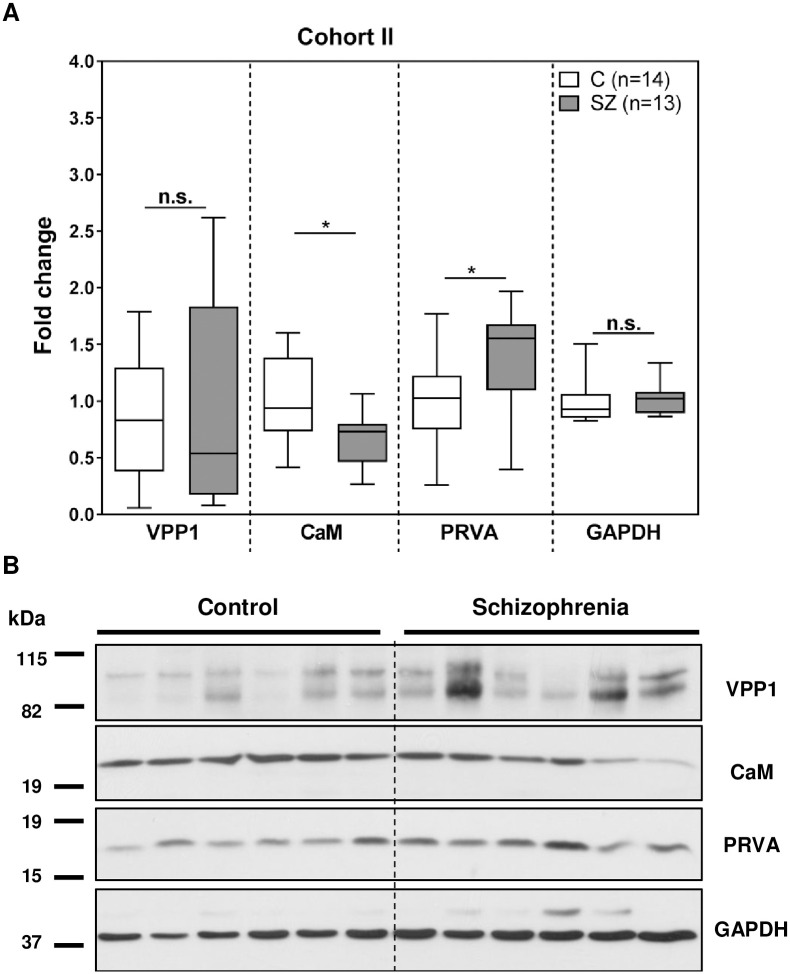
Validation analysis of hit candidate proteins by immunoblot in Cohort II.Protein extracts from samples of the post-mortem cerebellum of non-suicide chronic schizophrenia (SZ, n = 13) and control (C, n = 14) subjects (Table 1, Cohort II) were analysed by immunoblot for the same proteins as in Fig 1A and quantified by densitometry. (A) Protein levels for each protein were normalized to GAPDH values and to the mean of the control samples. Each box plot represents the median, interquartile range, and range of each group from at least two independent determinations. An outlier was detected for VPP1 protein values in the control group. Statistical analysis for comparison between case and control groups was performed using the t test for VPP1 and PRVA and the Mann-Whitney U test for CaM and GAPDH (n.s.-not significant, *p<0.05, ***p<0.001). (B) Representative Western blot images for VPP1, PRVA, CaM and GAPDH in 6 non-psychiatric control individuals and 6 non-suicide schizophrenia subjects from set 2. See S2 Raw images for complete western blot images.